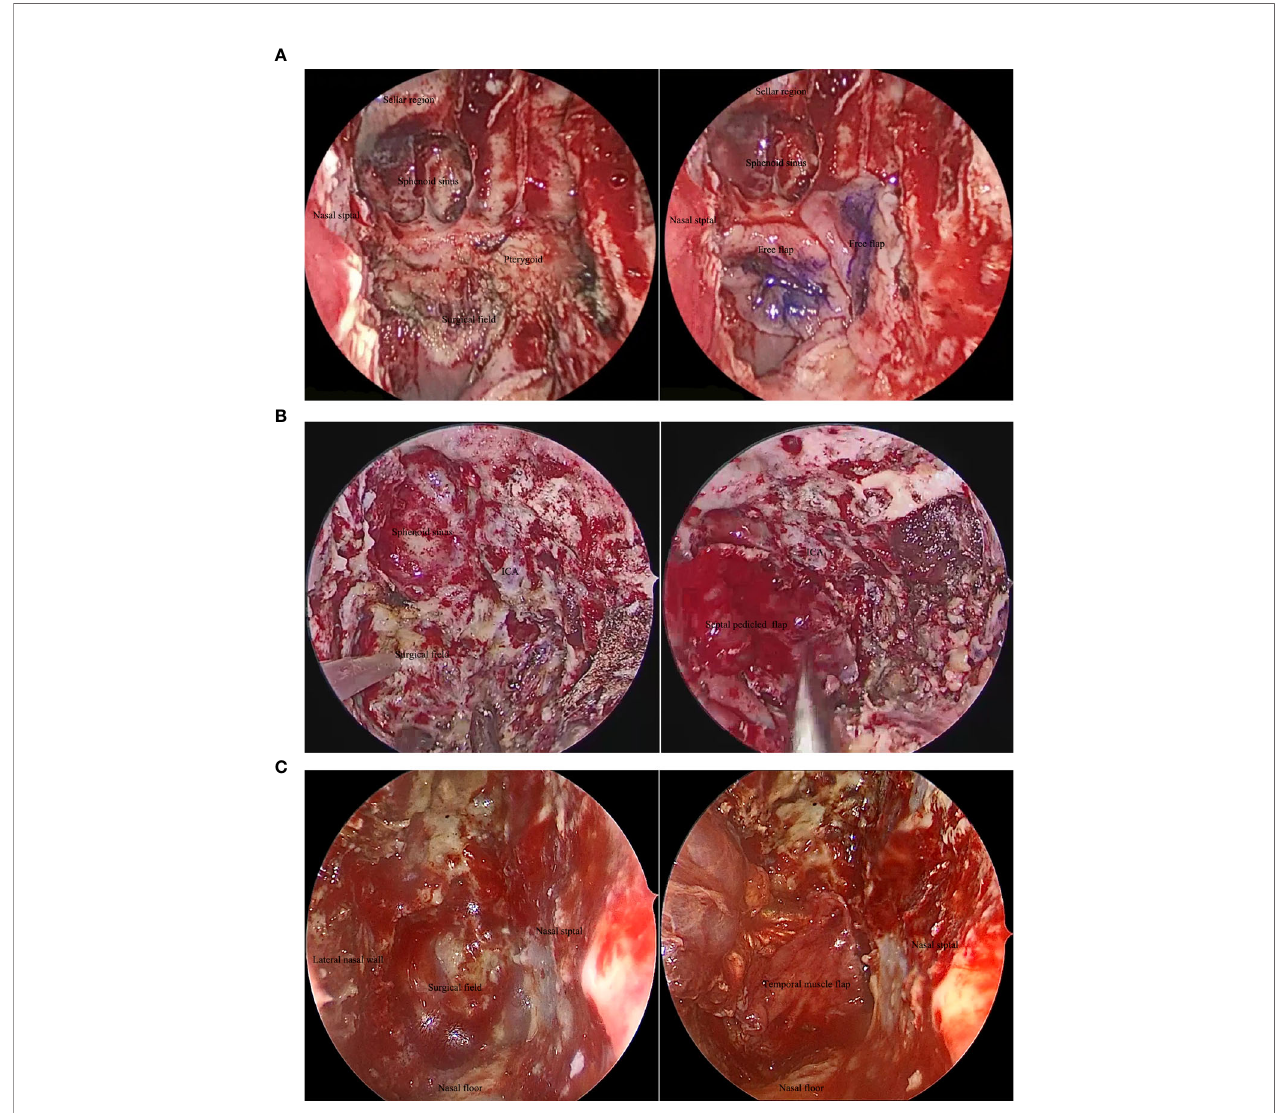
FIGURE 2 | Reconstruction of skull base defect after salvage surgery for recurrent nasopharyngeal carcinoma: (A) nasal free fl ap; (B) septal pedicled fl ap; and (C) temporal muscle fl ap. ICA, Internal carotid